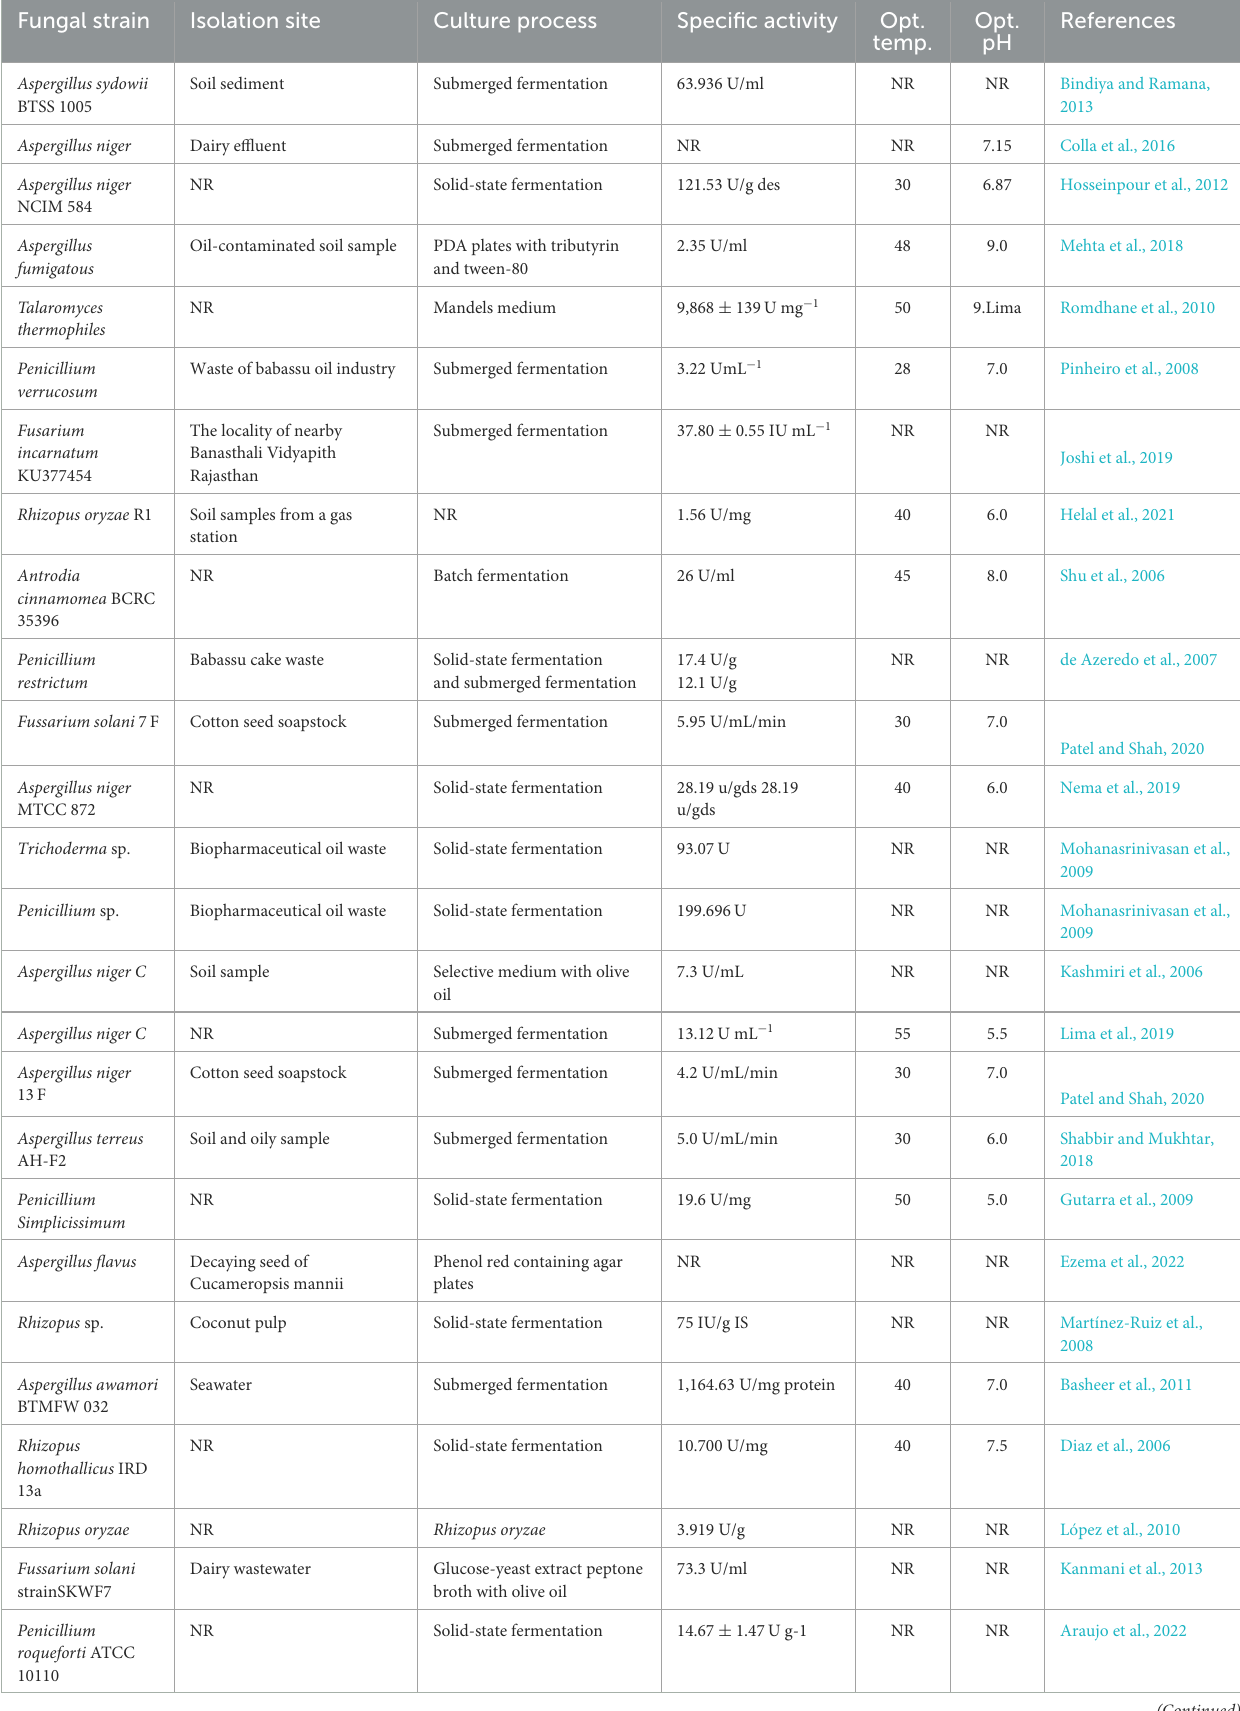
TABLE 1 The names of some fungi, their isolation sites, culture processes, and enzymatic activities. Fungal strain Isolation site Culture